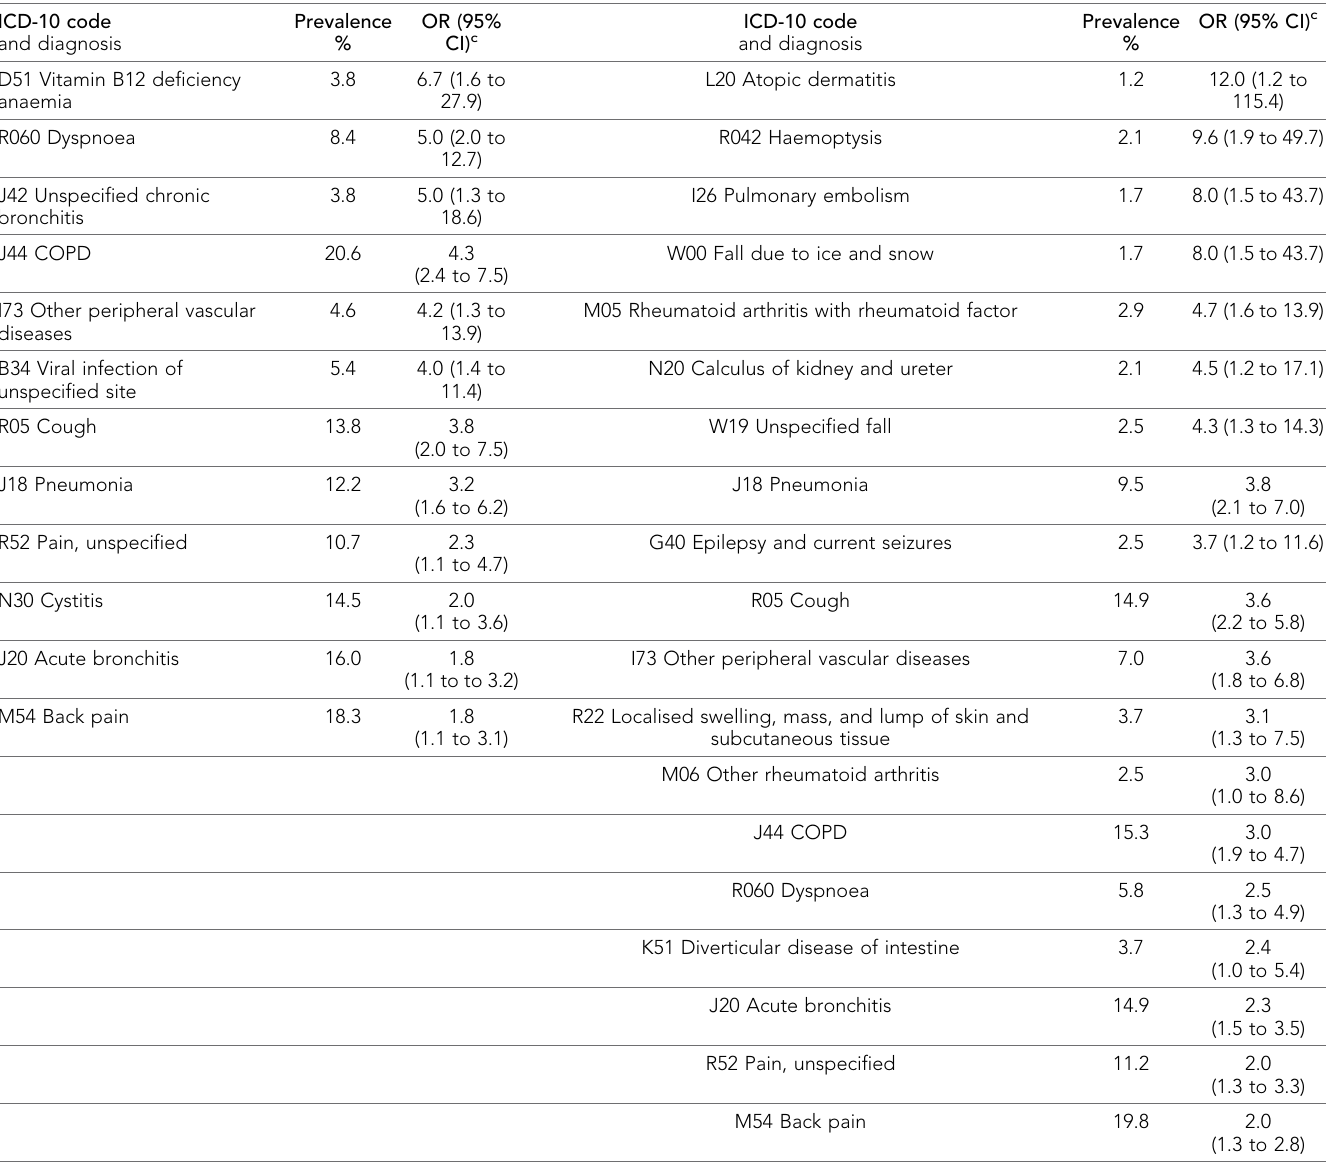
Table 2. Univariable analysis of diagnoses depending on stage with odds ratio >1.5 a in patients in primary care during 12 months before lung cancer diagnosis Stage I–III (M0 b